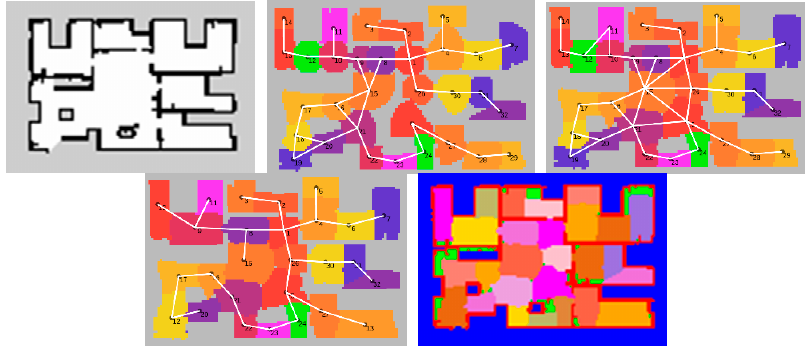
Figure 6. Topological map construction process.